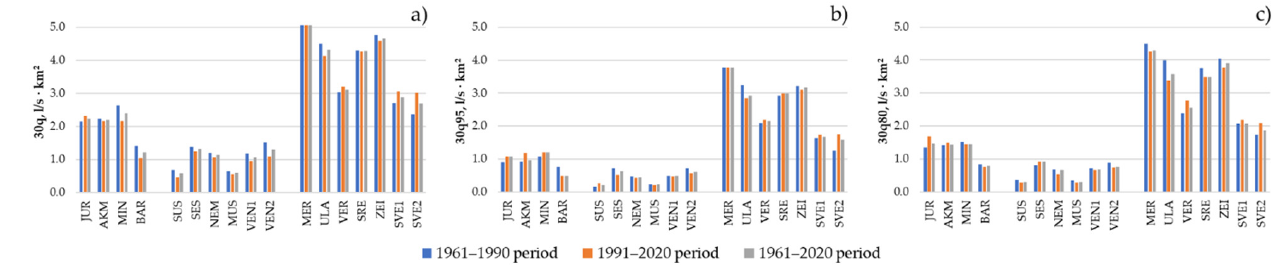
Figure 5. Temporal changes of low-flow indices in three periods: ( a ) 30q, ( b ) 30q95, and ( c ) 30q80 .